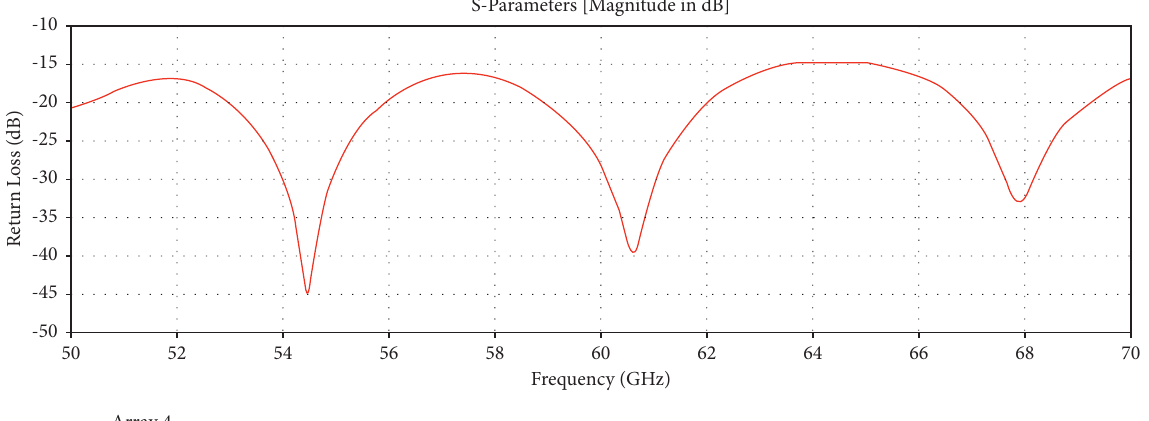
Figure 6: Simulated free-space return loss of Array